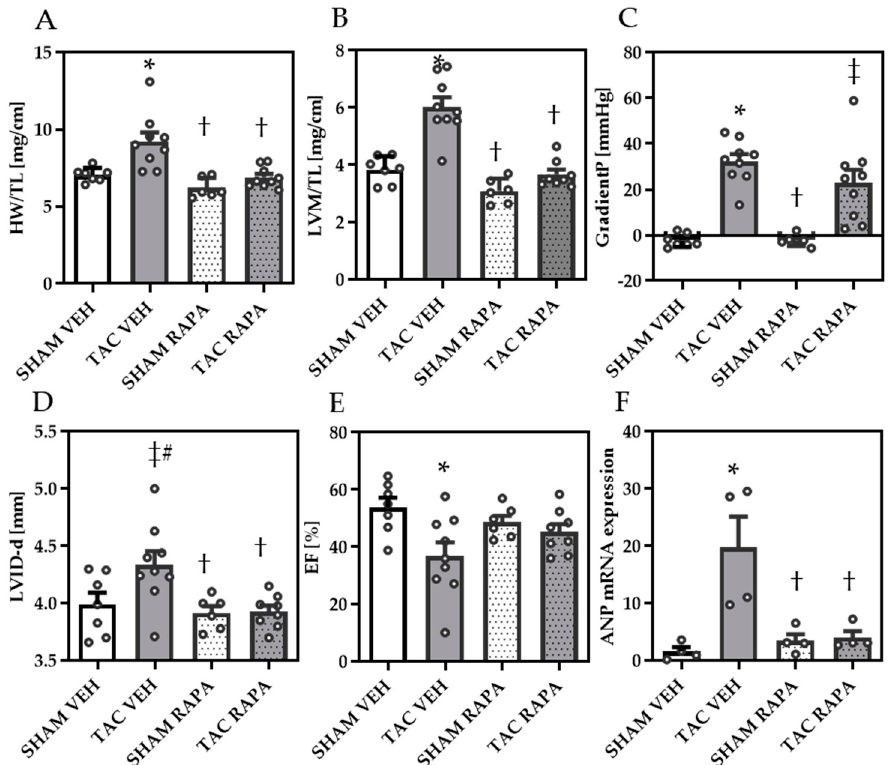
Figure 1. Pressure overload-induced heart failure is ameliorated by RAPA treatment. ( A ) Heart weight to tibia length (HW/TL). ( B ) Echocardiographic-assessed left ventricular mass matched to tibia length (LVM/TL). ( C ) Gradient P determining degree of aortic banding. ( D ) Echocardiographic-assessed diastolic left ventricular internal diameter (LVID-d). ( E ) Ejection fraction (EF). ( F ) Relative gene expression of atrial natriuretic peptide (ANP). Data are revealed 10 weeks post-surgery and presented as Mean + SEM of biological replicates. Statistical analyses were performed by either two-way-ANOVA followed by Bonferroni posttest or unpaired t- test (indicated with #). Significant differences are shown by p < 0.05, * vs. SHAM VEH, † vs. TAC VEH, ‡ vs. SHAM RAPA. Doppler echocardiography revealed increased pressure gradients (GradientP) in TAC- mice, yet not significantly different between TAC VEH and TAC RAPA mice ( p =